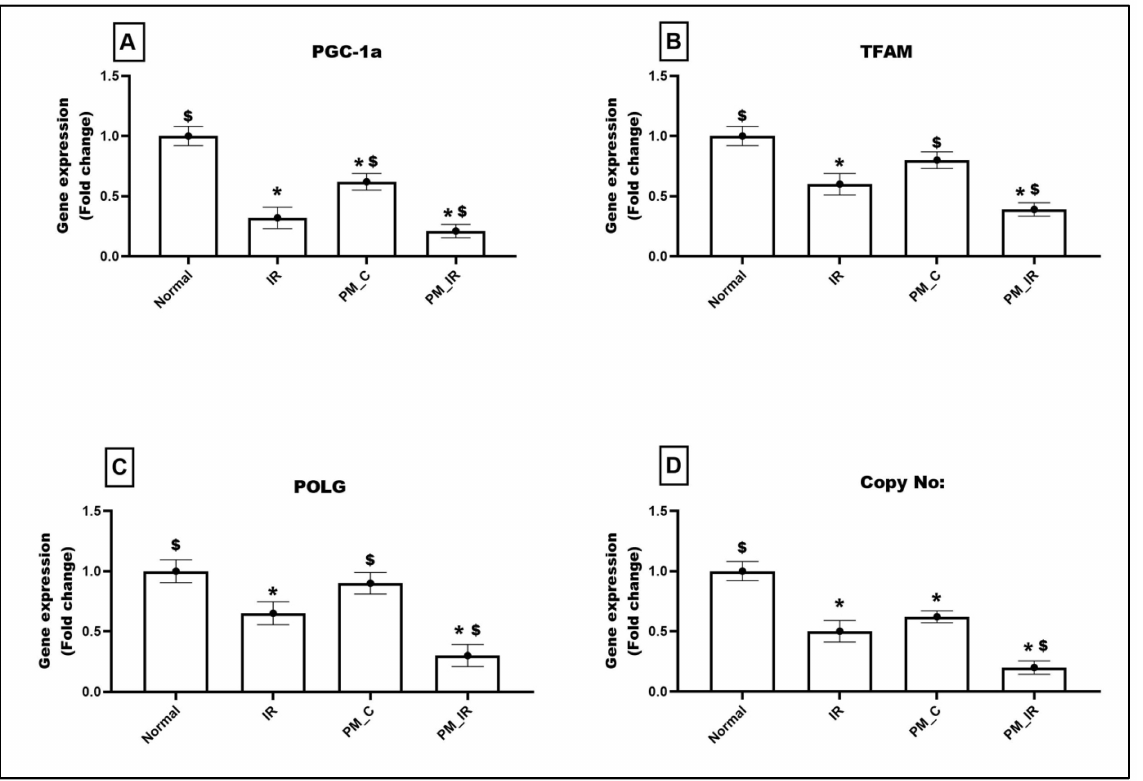
Figure 6. mRNA expression changes of ( A ) PGC1-a, ( B ) TFAM, ( C ) POLG, and ( D ) DNA copy number in the myocardium. Values are mean ± SD. Significant difference from control group is indicated by asterisk (* p < 0.05, $ p < 0.05 vs. IR control). [Groups: (1) Normal, (2) IR, (3) PM_C, (4)